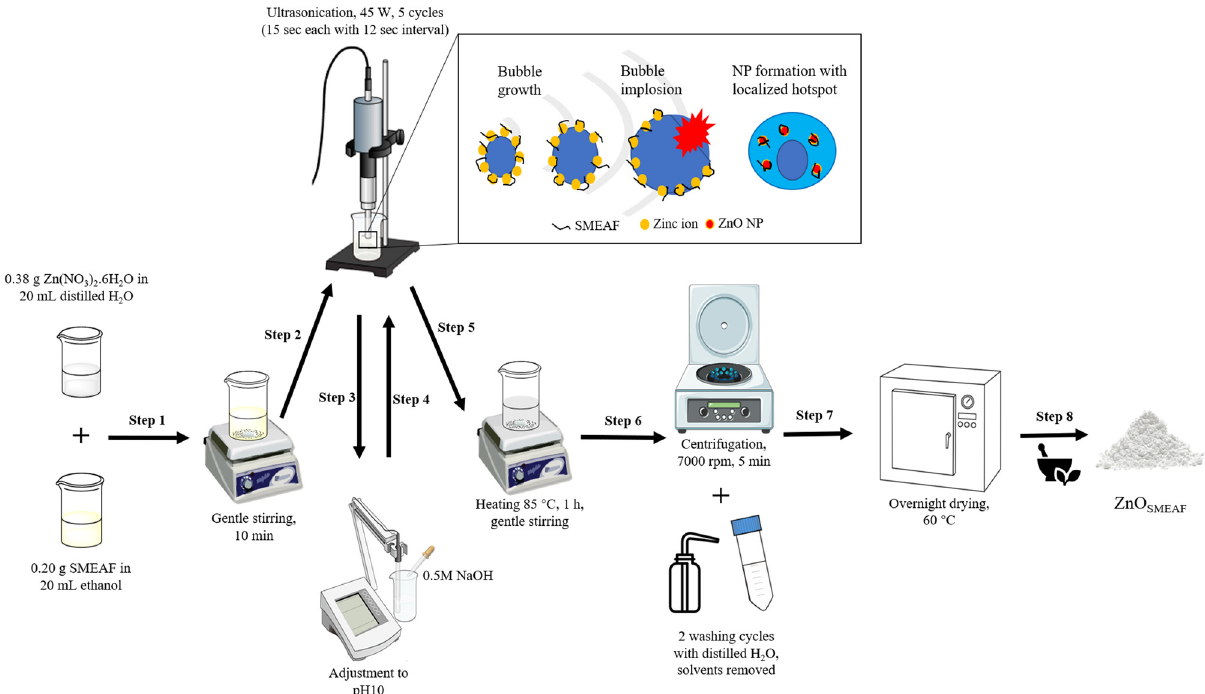
Figure 1: Schematic of the synthesis and the in fl uence of ultrasound on the formation of ZnO SMEAF ( inset )